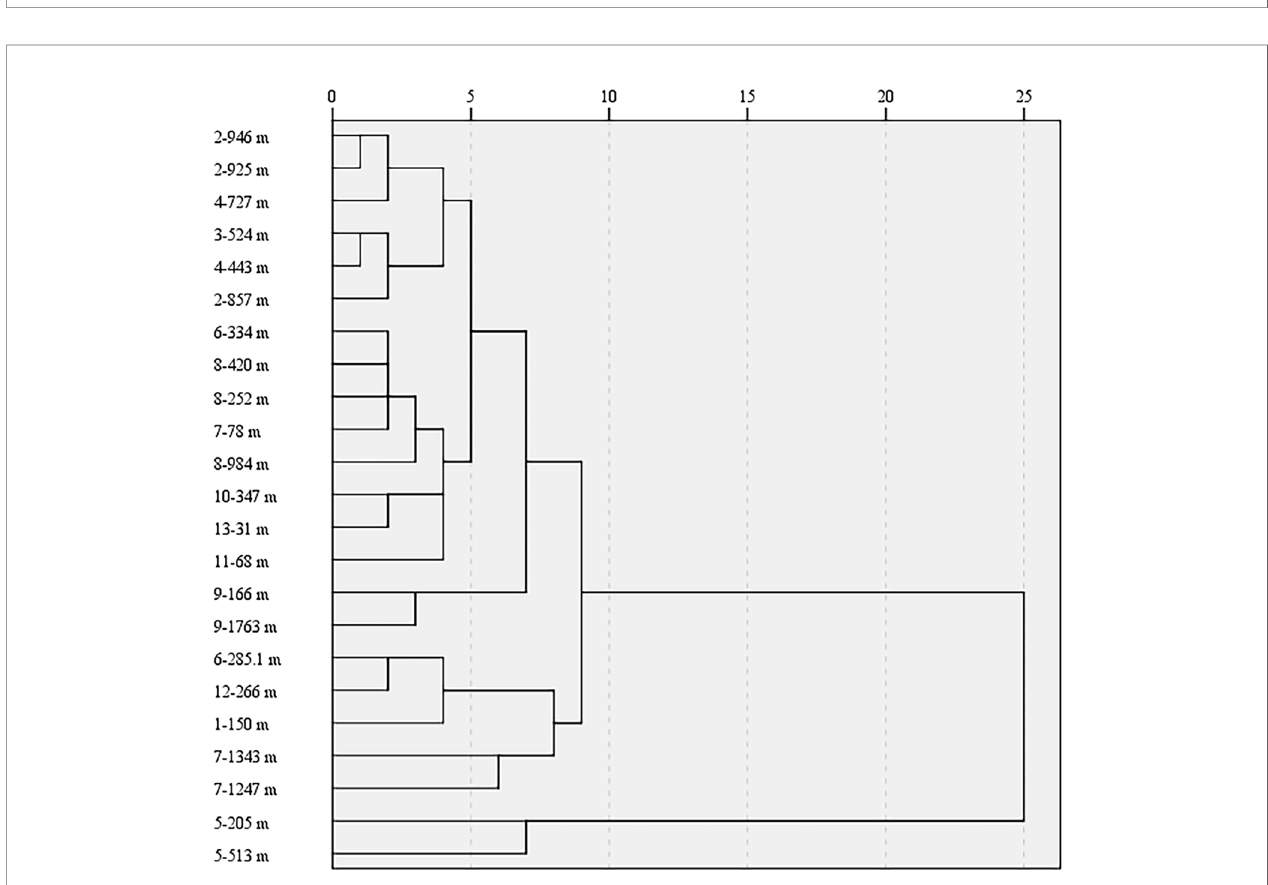
FIGURE 8 | The exploratory analysis results of Eucommia ulmoides leaves (EUL) samples in soil type (A) : The distribution of each collection site; (B) : PCA; (C) : t-SNE.